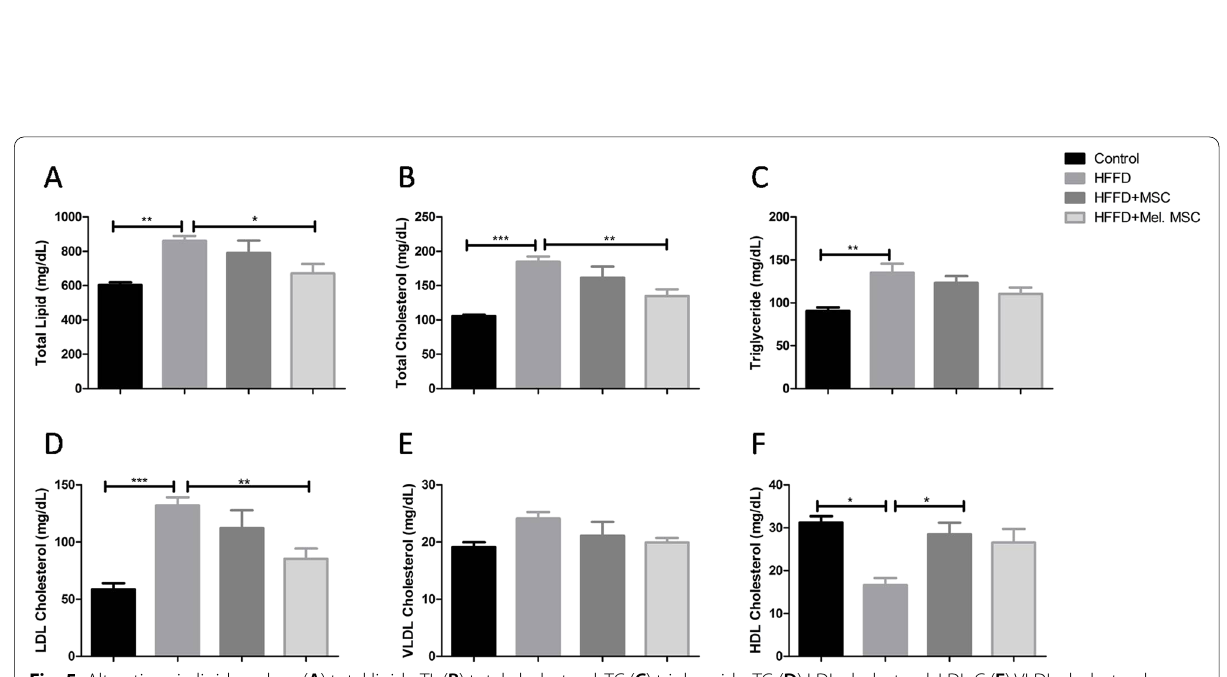
Fig. 5 Alterations in lipid markers ( A ) total lipids; TL ( B ) total cholesterol; TC ( C ) triglyceride; TG ( D ) LDL cholesterol; LDL-C ( E ) VLDL cholesterol; VLDL-C ( F ) HDL cholesterol; HDL-C. Data expressed as